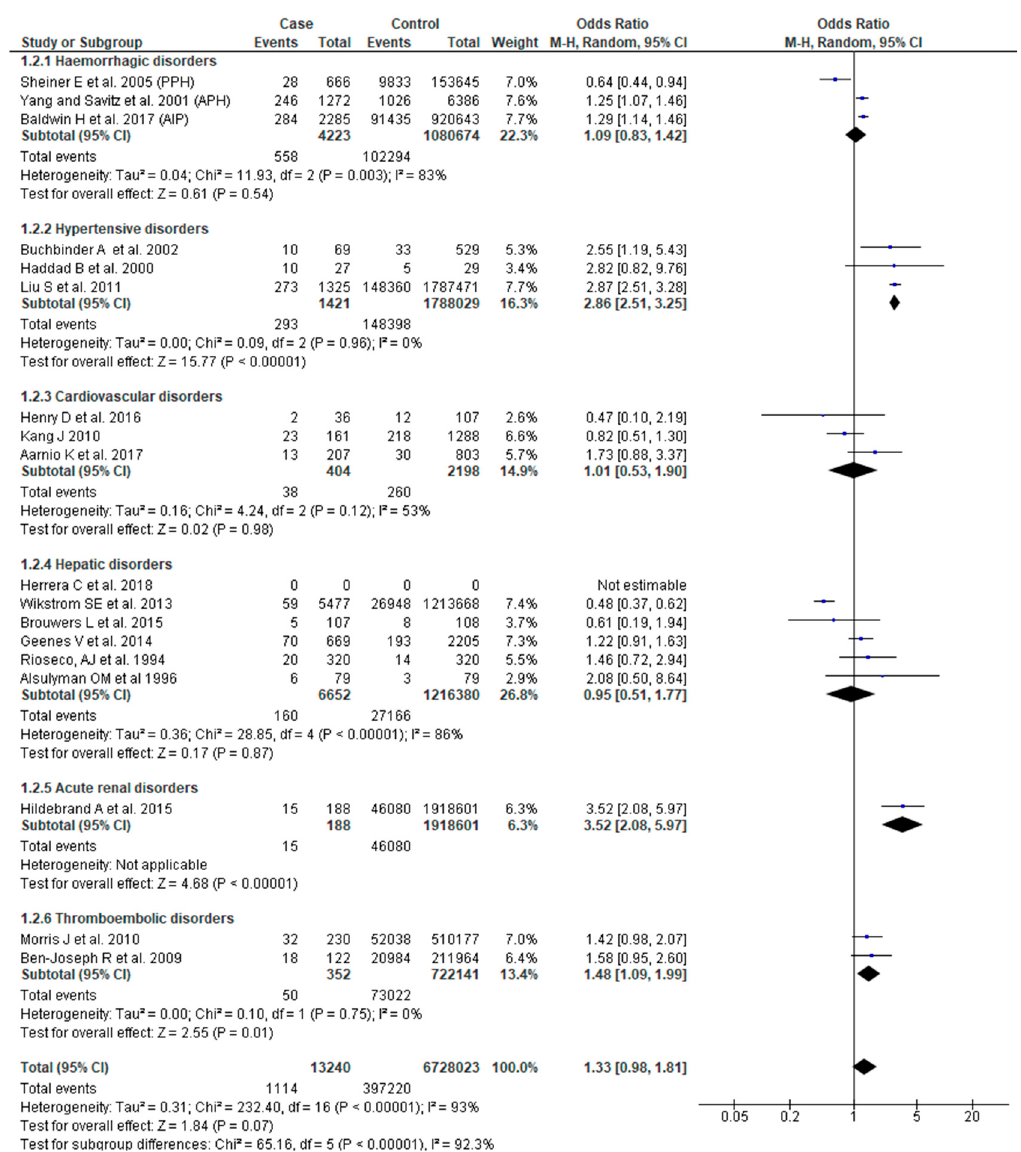
Figure 3. Forest plot of studies assessing association between SMM and infants being small for gestational age.